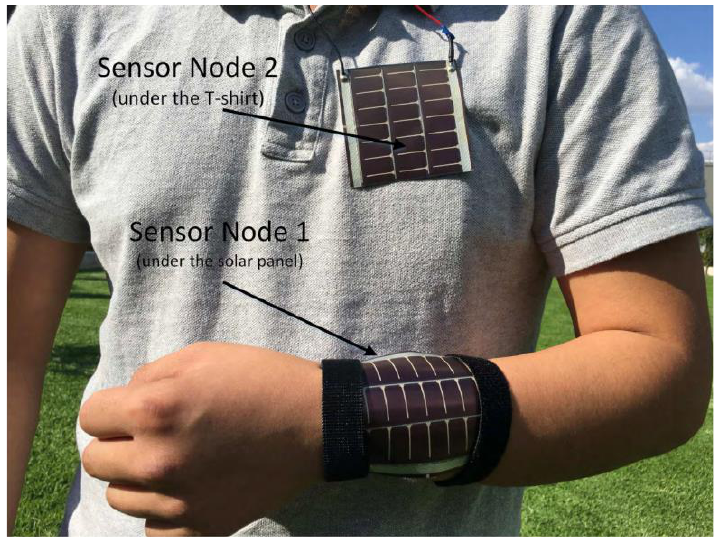
Figure 18. Wearable sensor with solar energy harvesting; source: [79] (license: CC).